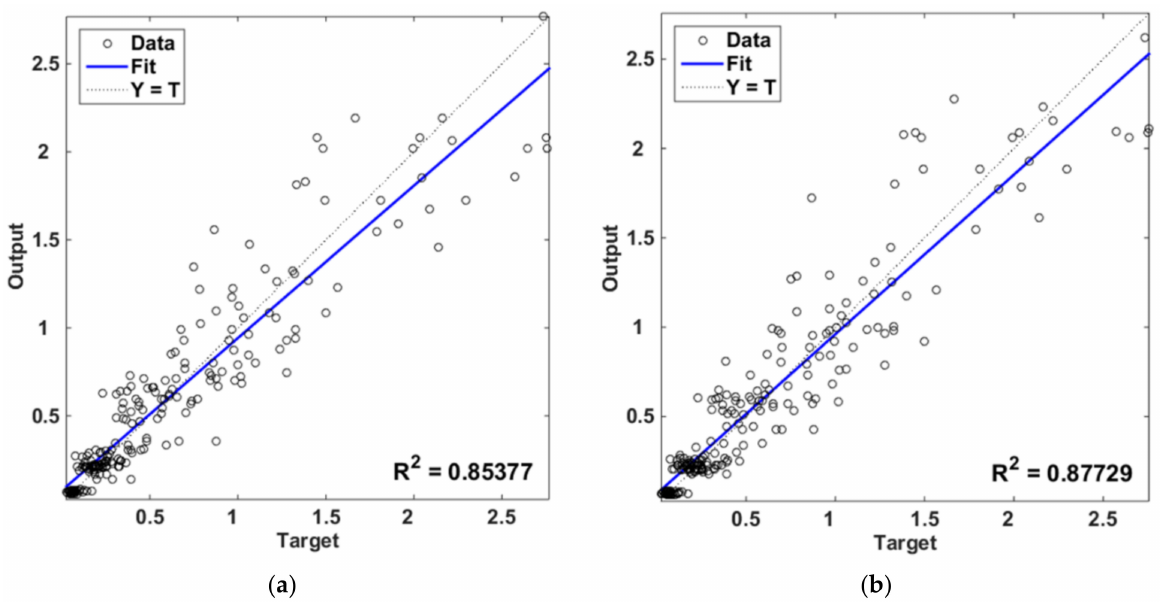
Figure 12. Regression plots of FFNN2 with BR and: ( a ) a single hidden layer having 50 neurons; ( b ) two hidden layers having 50 × 10 neurons.